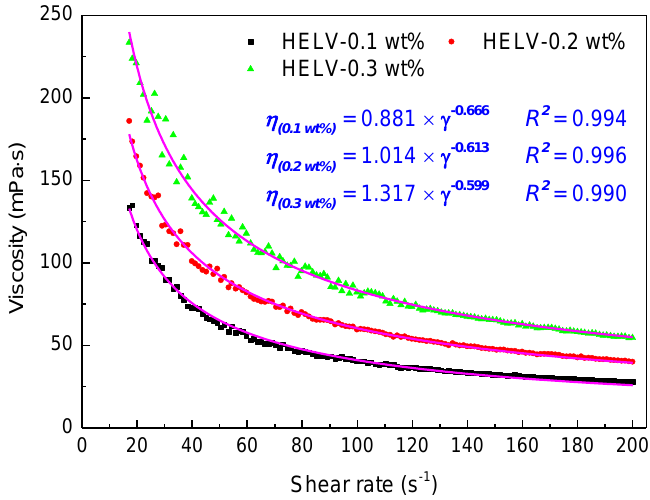
Figure 5. Shear viscosity versus shear rate profiles for HELV solutions at different concentrations.